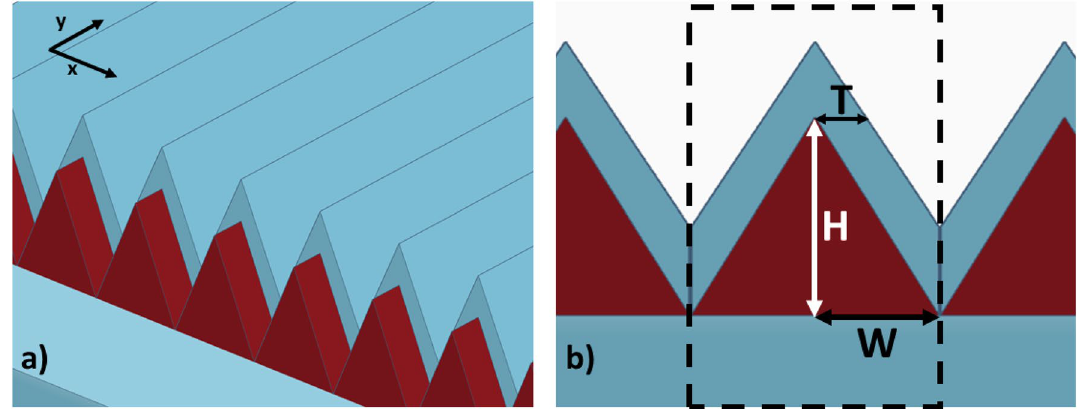
Figure 1. ( a ) 3D schematic of the structure showing doped silicon triangular nanoprisms in red and silicon substrate and coating in blue, ( b ) cross-section of the structure showing a unit cell in the dashed